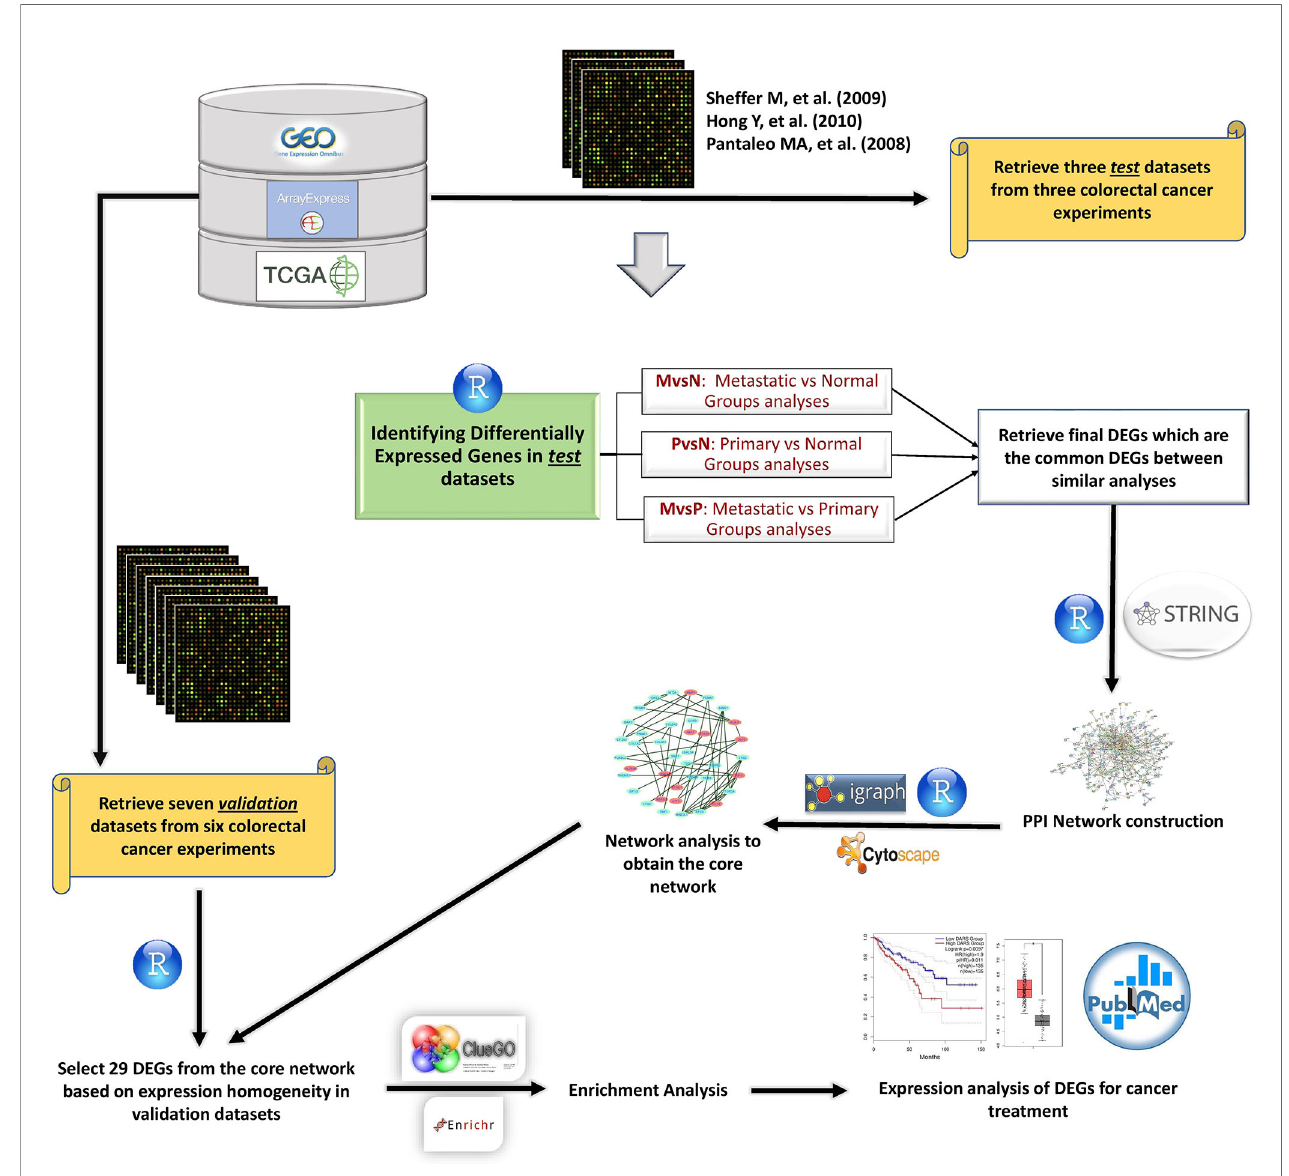
FIGURE 1 | The meta-analysis fl owchart to attain therapeutic genetic targets. Gene expression datasets were extracted from different databases. Data were analyzed and visualized using R programming language. DEGs were obtained from analyzing Test datasets, then veri fi ed by Validation datasets. STRING database was utilized to construct the PPI network from DEGs. R software was used to analyze the network. Cytoscape was employed to visualize the networks, and enrichment results were obtained from ClueGO Cytoscape plugin and Enrichr online tools. Next, survival analysis and expression pro fi ling were used for more validation of expression results. Finally, our results were compared to other studies, and molecular mechanism of validated DEGs was interrogated to propose a combination of target